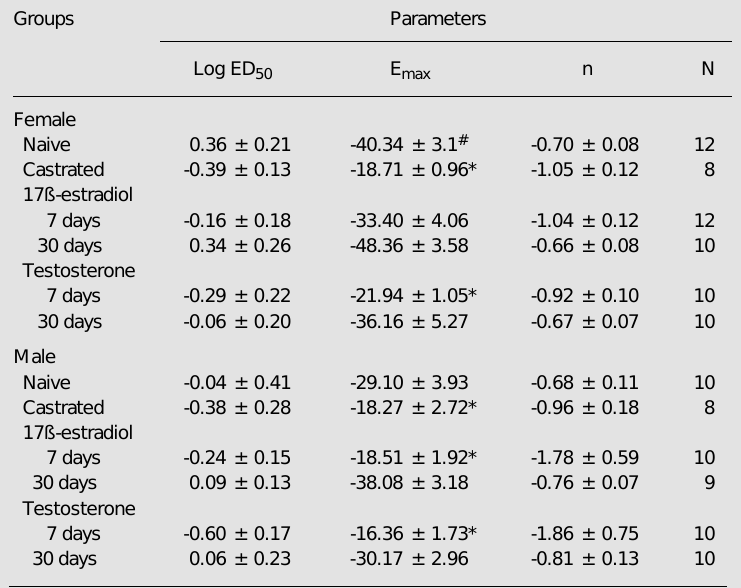
Table 2. Dose-response parameters for 5-HT-induced coronary vasodilation in hearts obtained from the following groups of male and female rats: naive, castrated, and castrated and treated with either estrogen or